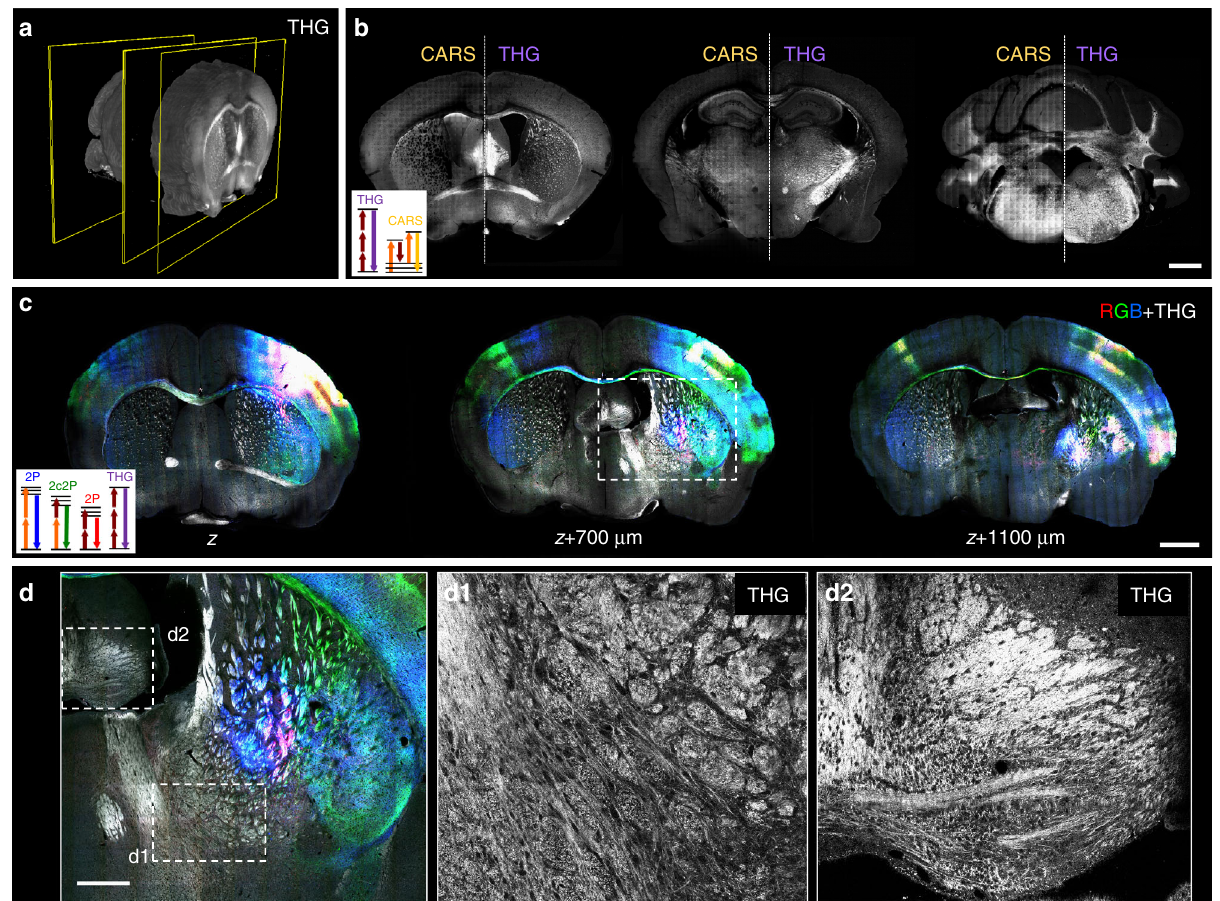
Fig. 7 Brain-wide multimodal imaging using endogenous nonlinear contrasts. a , b Label-free THG-CARS serial imaging. a Coronal 3D view from the